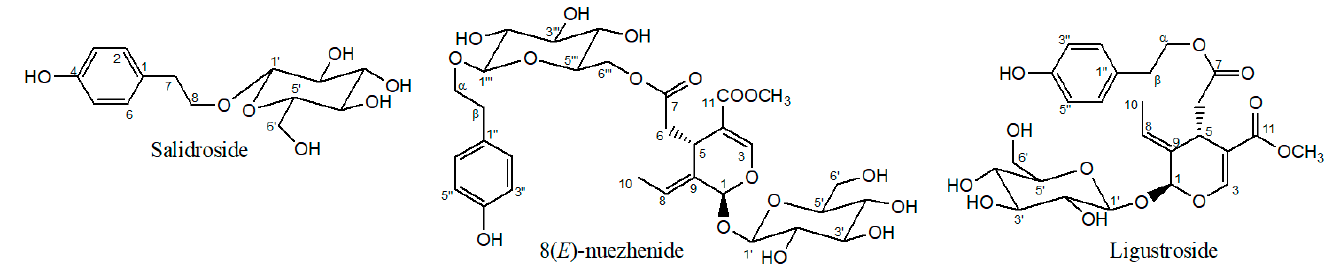
Figure 1. Chemical structures of isolated compounds salidroside (SAL), 8( E )-nuezhenide (NZD) and ligustroside (LIG) .